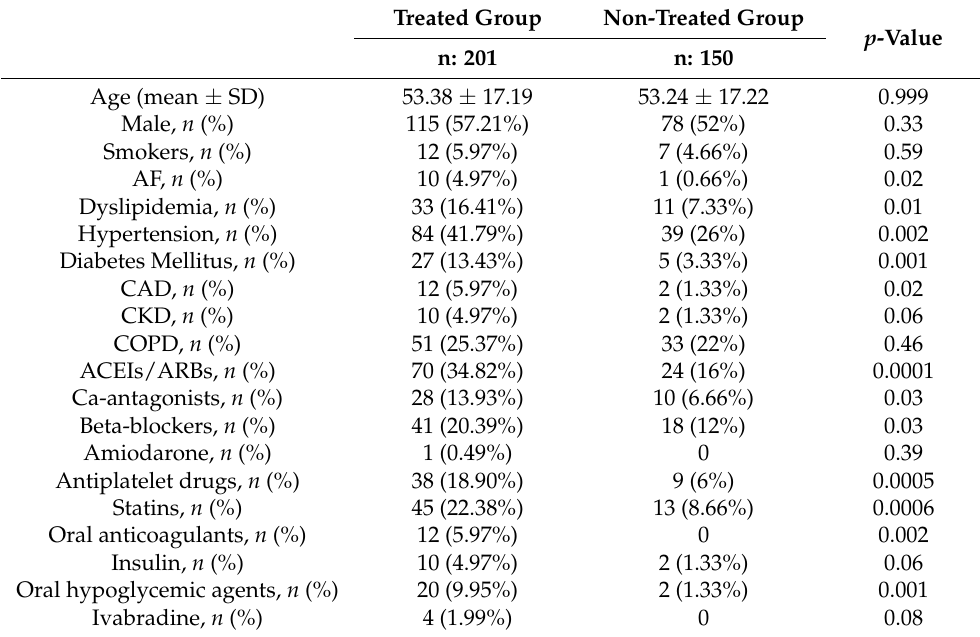
Table 2. Clinical features of patients treated with at least one experimental drug for COVID-19 versus not-treated